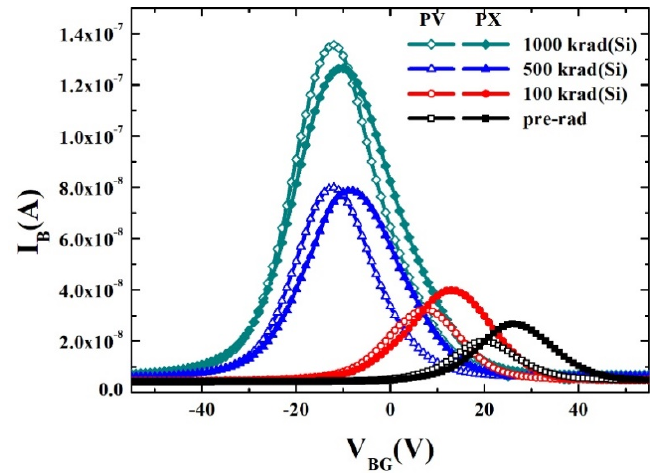
Figure 3. The experimental bulk current versus the back-gate voltage (I B -V BG ) characteristics under varying radiation doses: pre-rad (0 krad(Si)), 100 krad(Si), 500 krad(Si), 1000 krad(Si) in the devices with high-voltage well (PX) process (solid symbol) and low-voltage well (PV) technology (open symbol). V D , and V S were biased at 0.48 V; V FG was biased at 1.8 V.